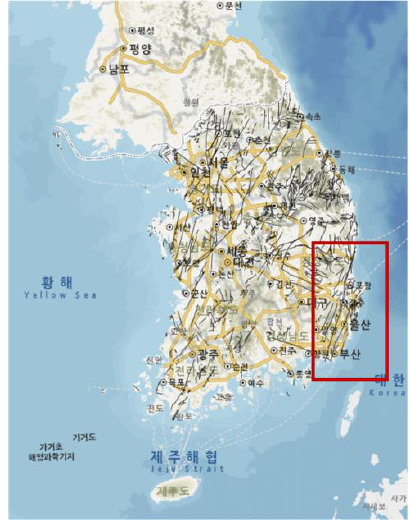
Figure 1. Yangsan Fault Zone marked in the red box.